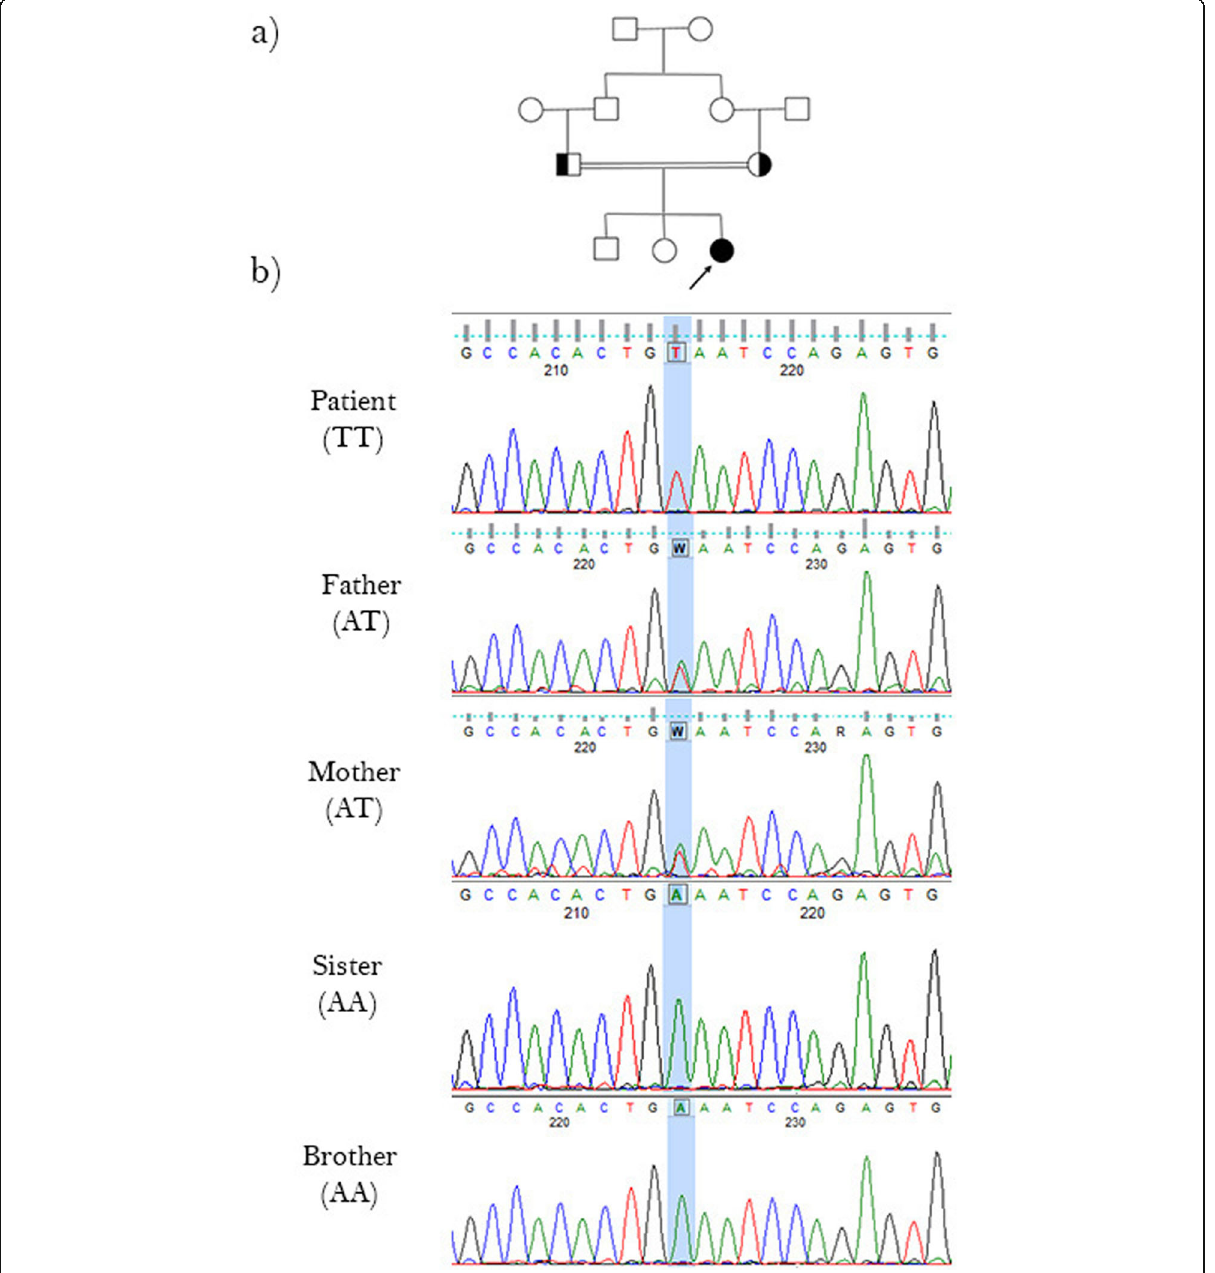
Fig. 1 Pedigree and Sanger sequencing details of the family. a The proband (marked by arrow) is a 22 year-old woman who is product of consanguineous marriage. b The autosomal recessive pattern of inheritance was confirmed in this family using Sanger sequencing based on identified homozygote mutation in the proband and heterozygote mutation in her